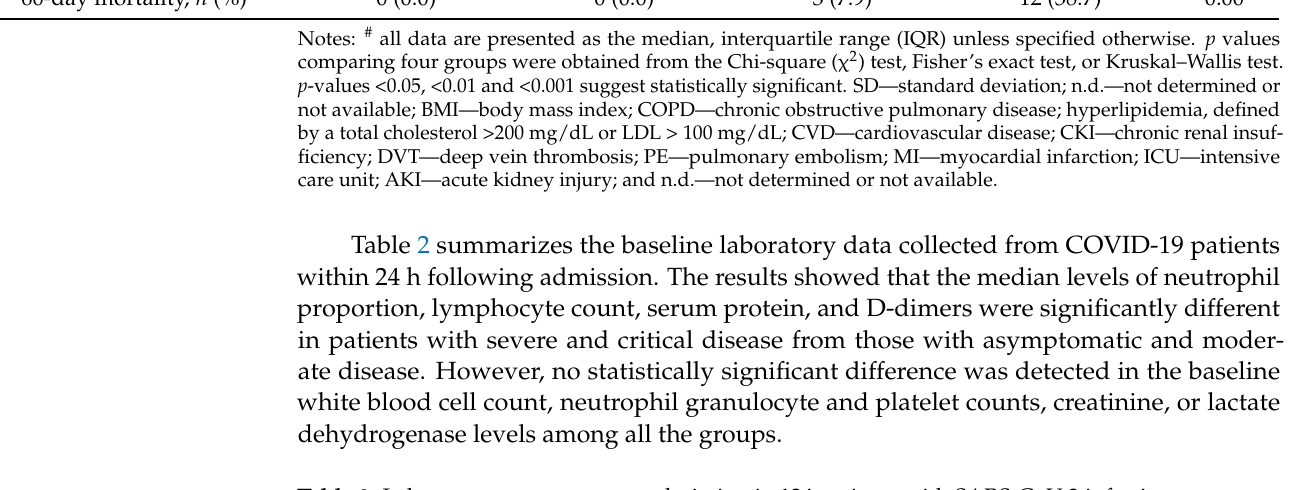
Table 2. Laboratory parameters on admission in 124 patients with SARS-CoV-2